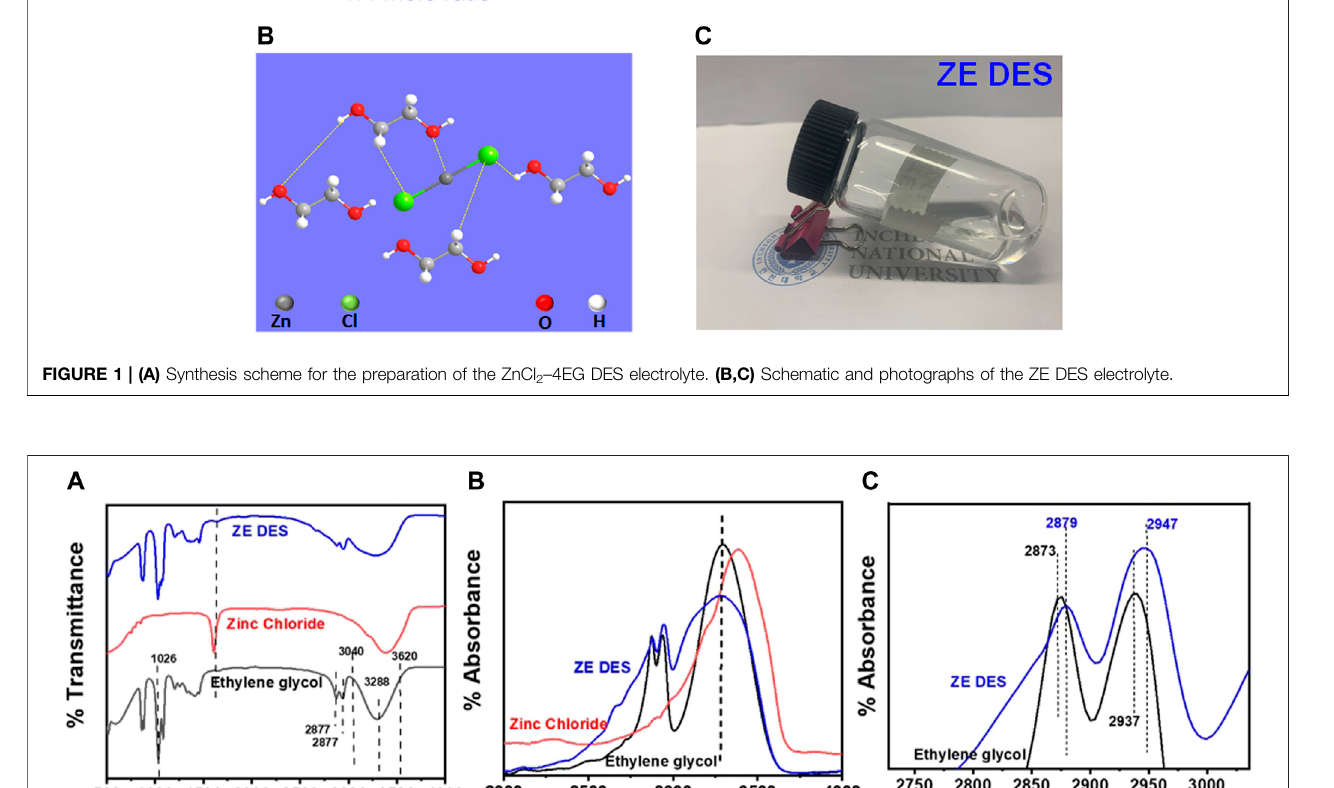
Figure 1A . The molar fraction between ZnCl to be 1:4, as it forms the most stable structure relative to other